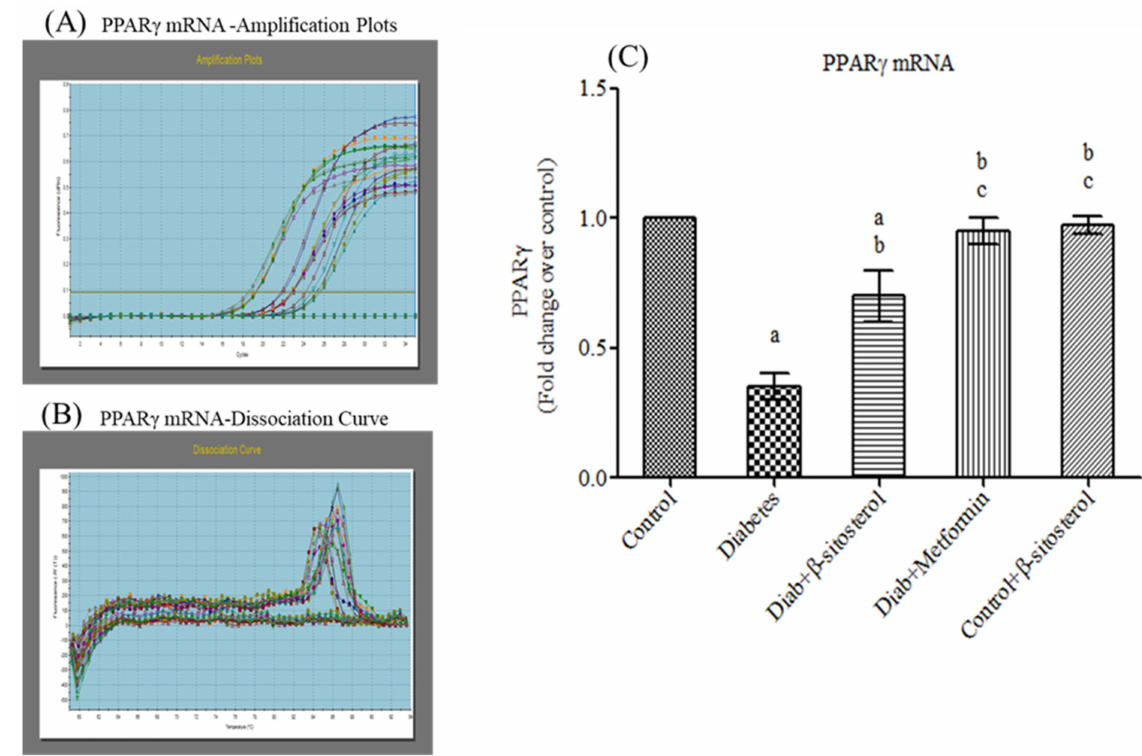
Figure 7. Effect of SIT on mRNA expression of PPAR γ in adipose tissue of type-2 diabetic rats. The mRNA expression of PPAR γ was assessed by real time-PCR. ( A ): Amplification plots; ( B ): dissociation curve analysis confirms the single product of PPAR γ mRNA and ( C ): mRNA expression is given in fold change. Each bar represents mean ± SEM ( n = 6). Significance at p < 0.05. a Significantly different from control group; b significantly different from diabetic group and c significantly different from β -sitosterol treated diabetic